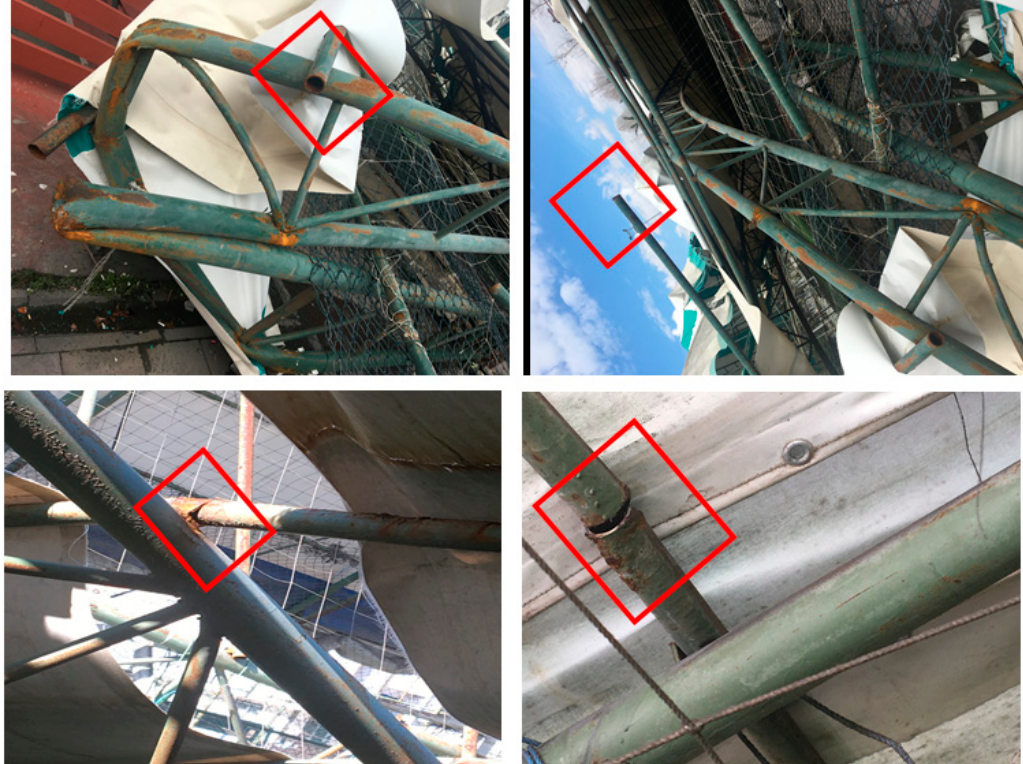
Figure 5. Observed damage on purlin connections.